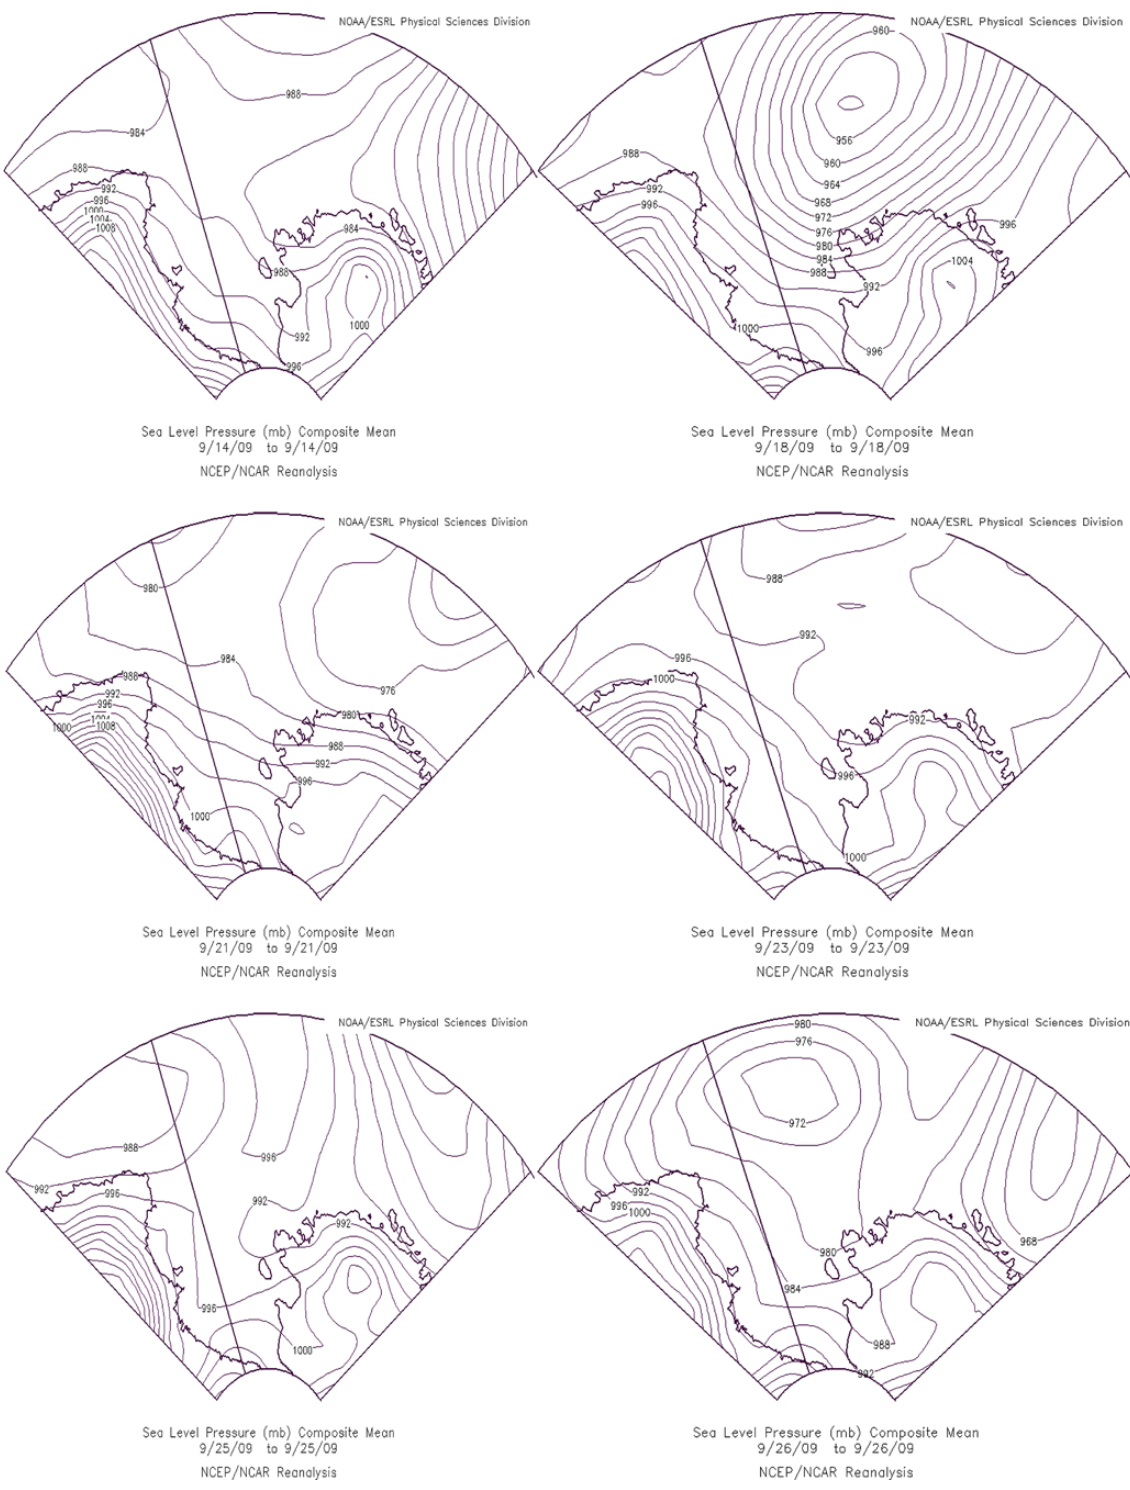
Figure 8. NCEP / NCAR reanalysis of mean sea level pressure data for the days on which flights were flown to TNB. Image provided by the NOAA / ESRL Physical Sciences Division, Boulder, Colorado, from their website at http: // www.esrl.noaa.gov / psd / (Kalnay et al., 1996).